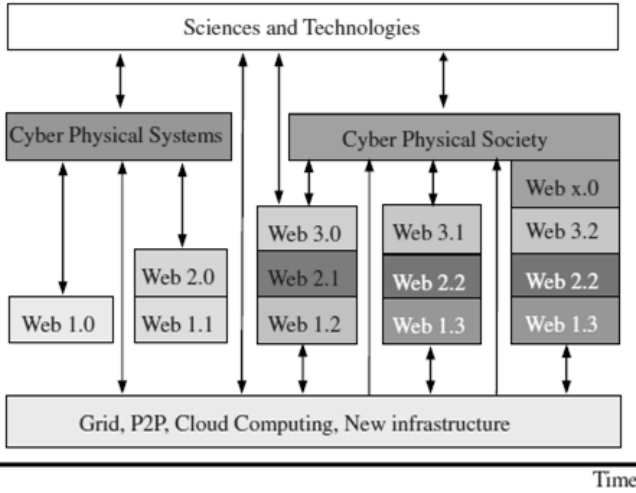
Figure 12. Cyber-Physical Society and other systems (see [59]).